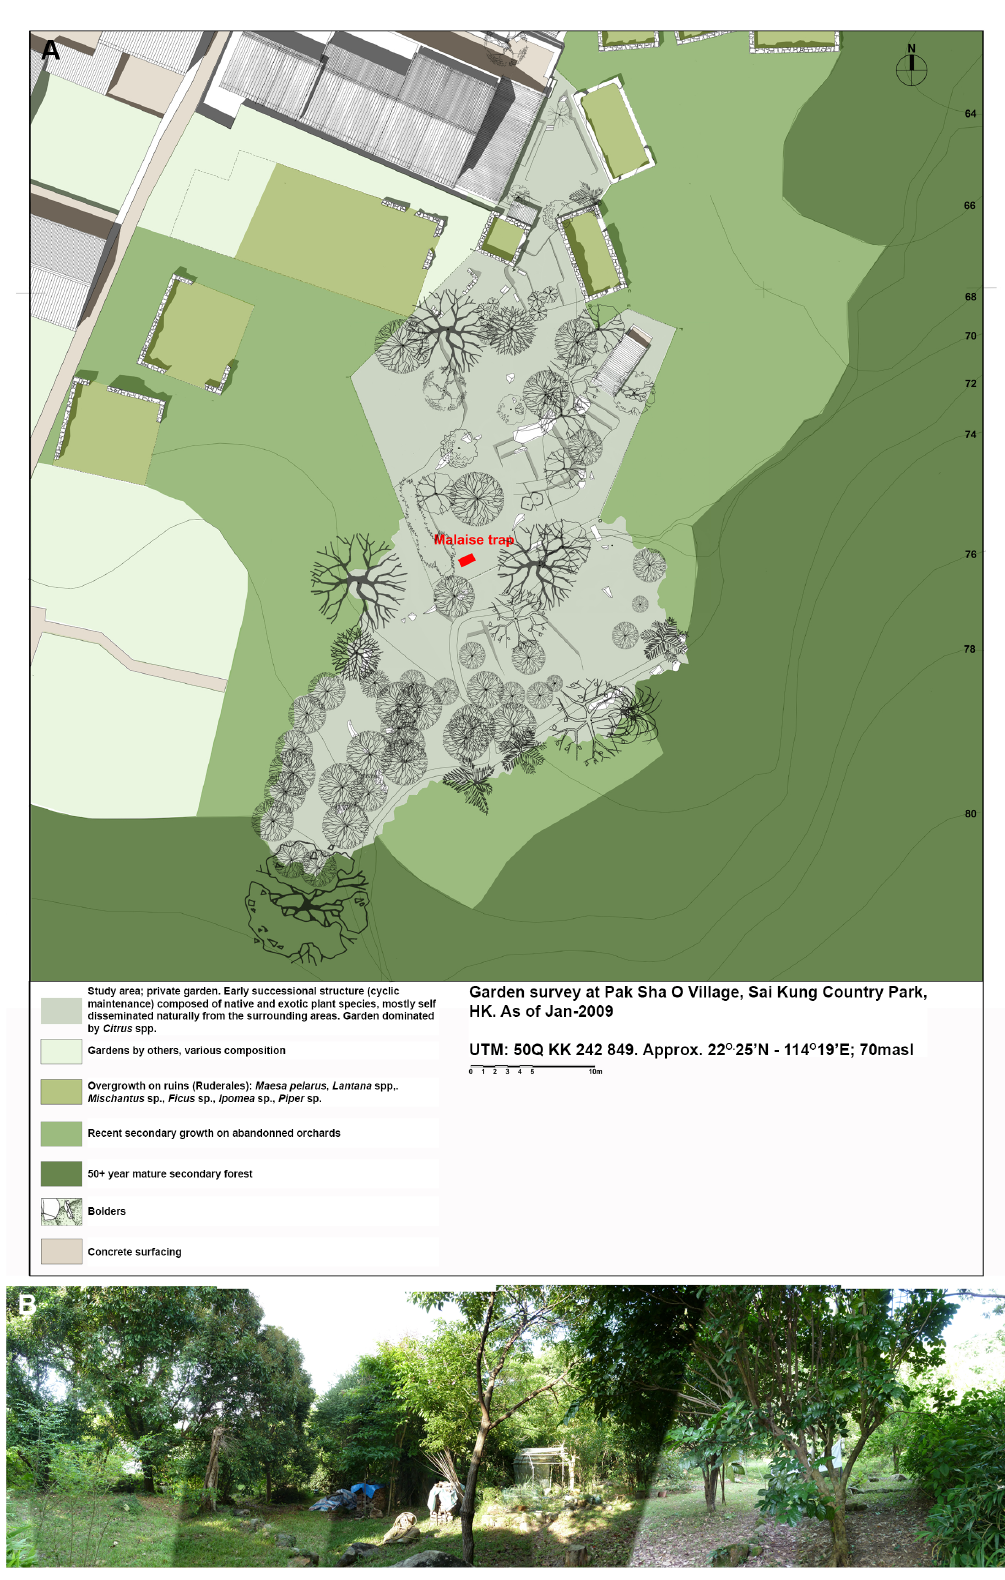
Fig. 3. A . Pak Sha O, Hong Kong, habitat of Palpostilpnus pterodactylus sp. nov. and P. trifolium sp. nov. Malaise trap surroundings. B . Panoramic shot of garden, Malaise trap on the far right (photo: Christophe